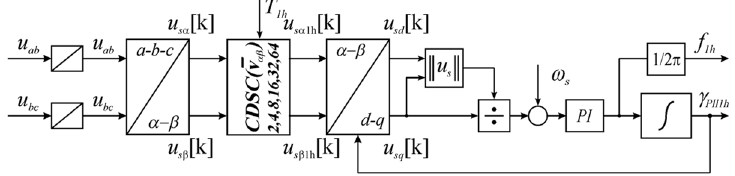
Figure 8. Block diagram of CDSC–PLL system.